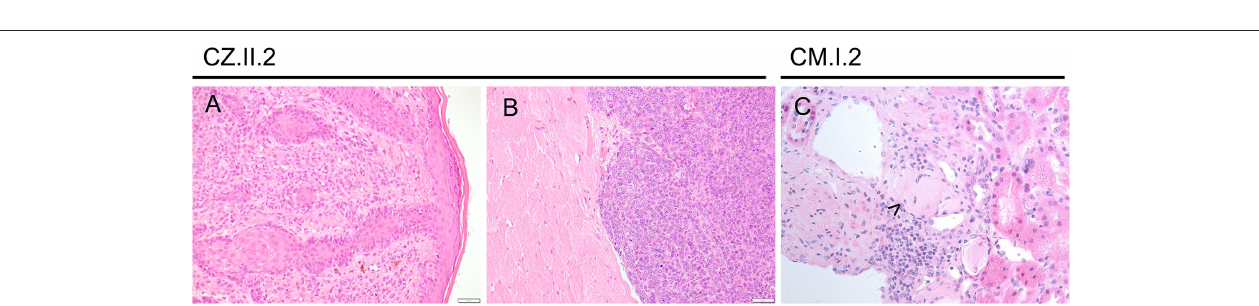
FIGURE 4 | Other malignancies in CTLA-4-insufficient-patients. (A) Superficial spreading melanoma of the ear (at the age 24 years) and metastasis ( B ; at the age of 25 years) infiltrating striated muscle fibers. (C) Amyloid deposits (highlighted by arrowhead) were immunohistochemically positive for amyloid p in this 75-years-old patient with multiple